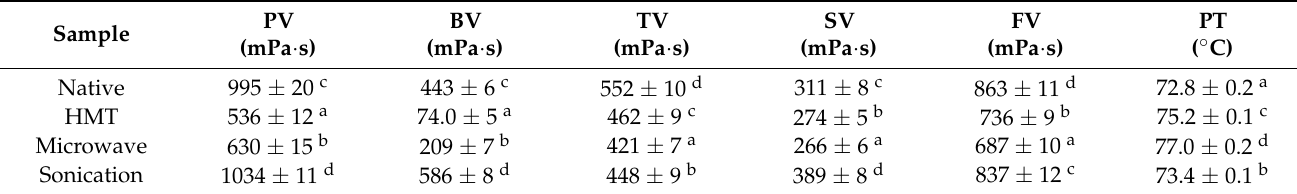
Figure 2. Pasting properties of native and modified starches. ( A ) Native starch ( B ) HMT ( C ) Mi- crowave ( D ) Sonication. Table 3. Pasting properties of native and modified